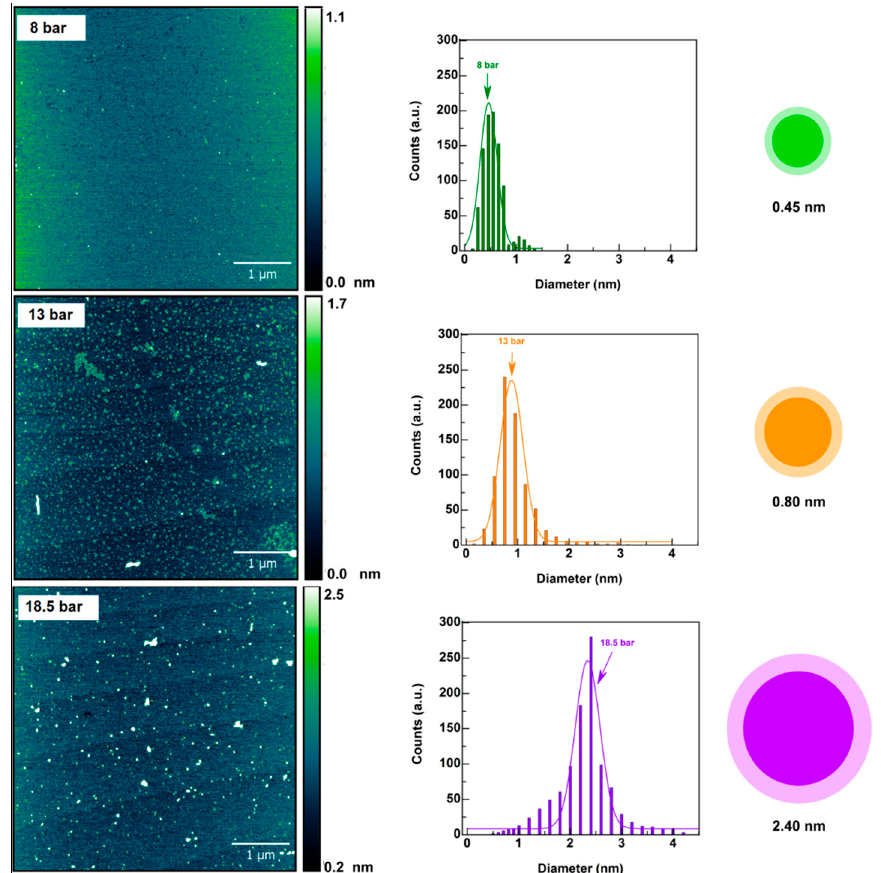
Figure 2. Atomic force microscopy (AFM) micrographs of CDs obtained at increasing pressure